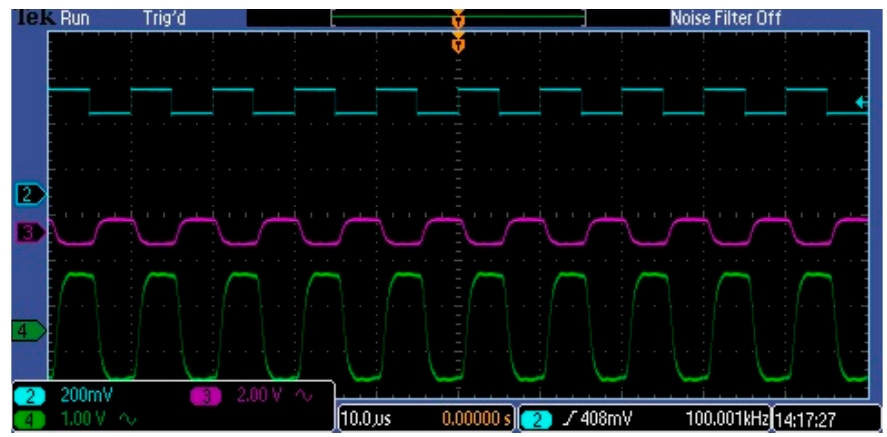
Figure 16. Amplified pulse waveforms at 100 kHz. The green and purple waveforms represent amplified pulses in neighboring stages.